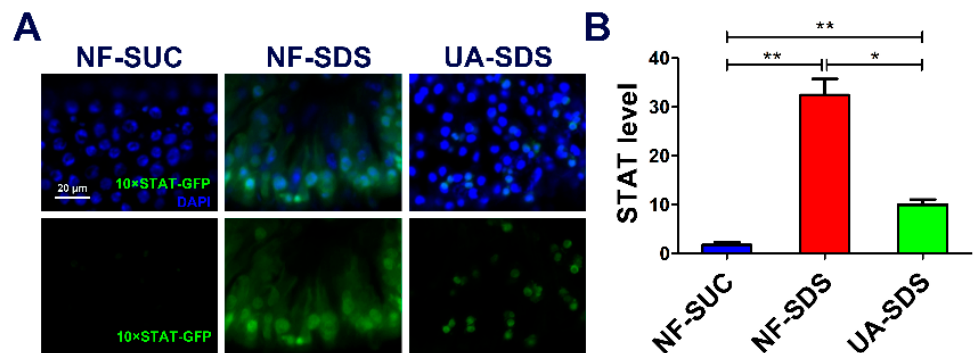
Figure 6. UA protected against SDS-induced injury via regulating JAK/STAT signaling pathway. ( A ) The JAK/STAT signaling was activated by SDS, and UA significantly attenuated the SDS-induced JAK/STAT activation. ( B ) Quantification of 10 × STAT-GFP levels in the intestines (n ≥ 6). * p < 0.05, ** p < 0.01.